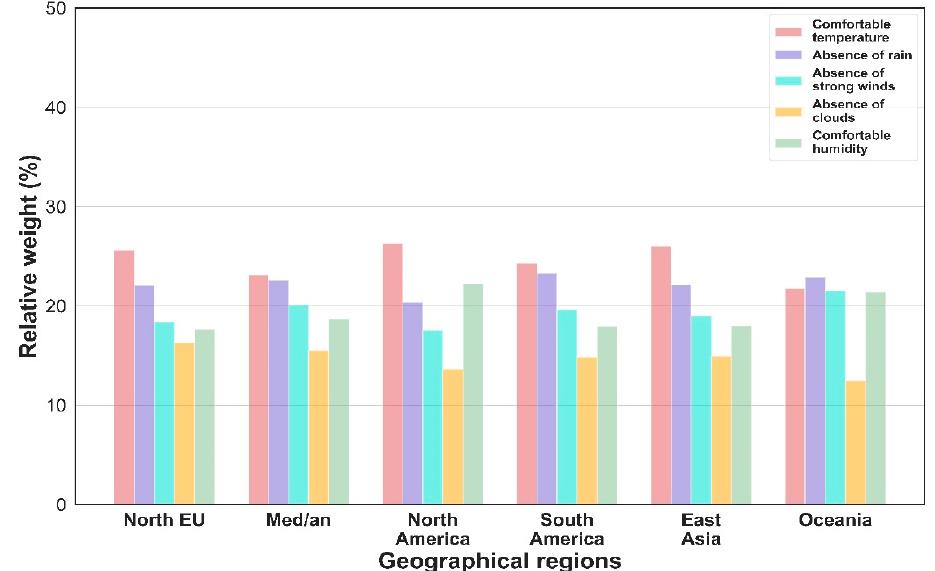
Figure 5. Weights of the different climate variables per nationality group.